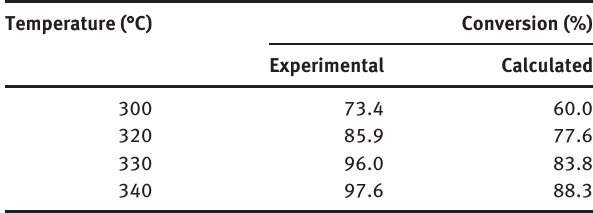
Table 1 Maximum methanol conversion reached in two